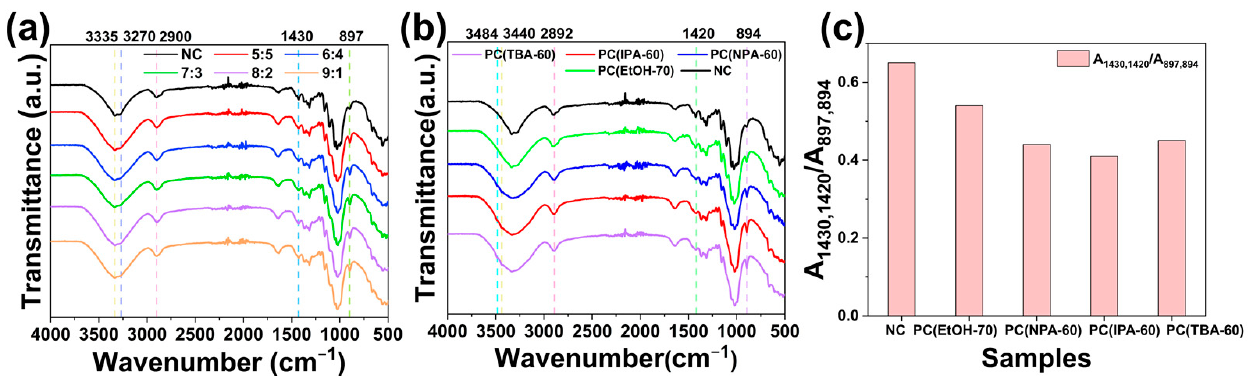
Figure 6. Comparison of FT-IR spectra of different cotton fibers: ( a ) NC and various PC(EtOH-100) with different V EtOH :V H ; ( b ) NC, PC(EtOH-70), PC(NPA-60), PC(IPA-60), and PC(TBA-60); ( c ) FT-IR absorbance ratios (A 1430,1420 /A 897,894 ) of NC and various pretreated fibers including PC(EtOH-70), PC(NPA-60), PC(IPA-60) and PC(TBA-60), respectively.